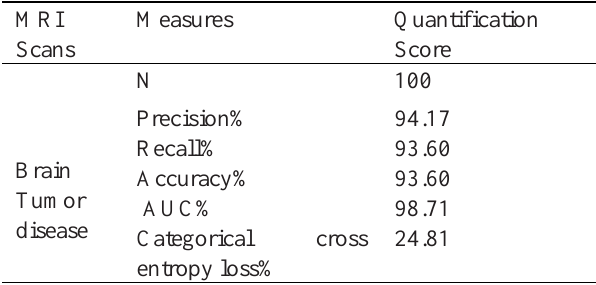
Attained performance metrics results